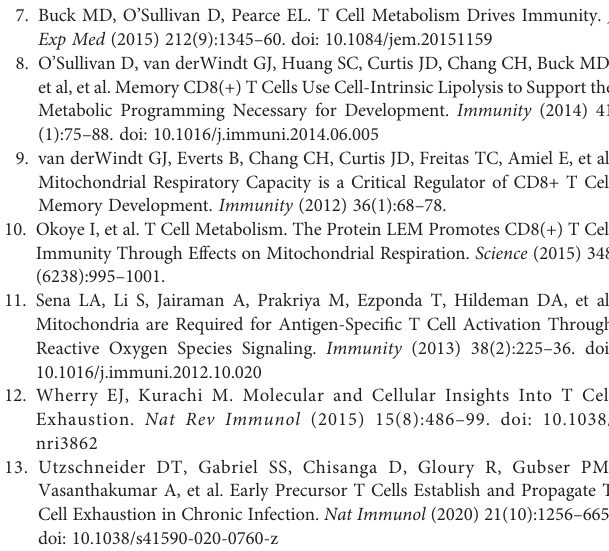
Supplementary Figure 3 | Similar level of Glut-1 expression was detected in Gag-speci fi ccomparedtoCMV-speci fi cCD8TcellsfromHIV-1Elitecontrollers. (A) Representative fl ow plots and summary data of percentage of PD-1 + or PD- 1 + TIGIT + double-positive cells within Gag-speci fi c CD8 populations from n=5 elite controllers (ECs) and n=10 viraemic HIV-1 positive donors (HIV-1) (B) A representative histogram overlay of Glut-1 MFI in global, Gag- and CMV-speci fi c CD8 T cells from n=5 ECs and summary data comparing Glut-1 MFI in global and Gag- or CMV-speci fi c CD8 T cells in paired samples. Supplementary Figure 4 | Assessment of mitochondrial membrane potential. (A) Representative fl ow plots and (B) summary data of JC-1 red/green ratio in n=4 HIV-1 negative and HIV-1 viraemic donors. Mitochondria polarization and depolarization state is indicated by red and green fl uorescence, respectively. (C) A representative fl ow plot of JC-1 red/green expression in global and overlaid T- bet low EOMES hi PD-1 + CD8 T cells (shown in green). (D) Paired data of the JC-1 red/ green ratio in global CD8 T cells and T-bet low EOMES hi PD-1 + CD8 T cells from n=4 HIV-1 positive individuals. Supplementary Figure 5 | Analysis of mitochondrial mass in exhausted subsets. (A) PCA analysis of aggregated fl ow cytometric parameters and correlation between measures and PCA component 1 and 2. (B) Participants ’ values for the principal component1inthestudygroups. (C) viSNEanalysisofmultiparametric fl owdatafrom concatenated fi les was performed on CD8 T cells from the CTR, EC, and HIV-1 positive groups showing marker intensity of Mitotracker, PD-1, TIGIT, EOMES, T-bet, CD38,CCR7,andCD45RA.EachpointontheviSNEmaprepresentsasinglecelland color depicts intensity of protein expression. (D) Distribution of intensity of Mitotracker is shown in a histogram form. (E) Comparison of Mitotracker MFI in PD-1 - , intermediate (Tex int ) and terminally exhausted (Tex term ) CD8 T cells in paired samples fromn=10viraemicHIV-1positivepatients.Signi fi cancedeterminedbyMann-Whitney U test, ns: non-signi fi cant, *p<0.05, **p<0.01. Supplementary Figure 6 | Analysis of ROS production following rotenone treatment. (A) Representative FACS plots of MitoSOX staining at basal level or following rotenone treatment (as positive control). (B) The percentage of MitoSOX + CD8 T cells in paired samples from n=3 HIV-1 negative